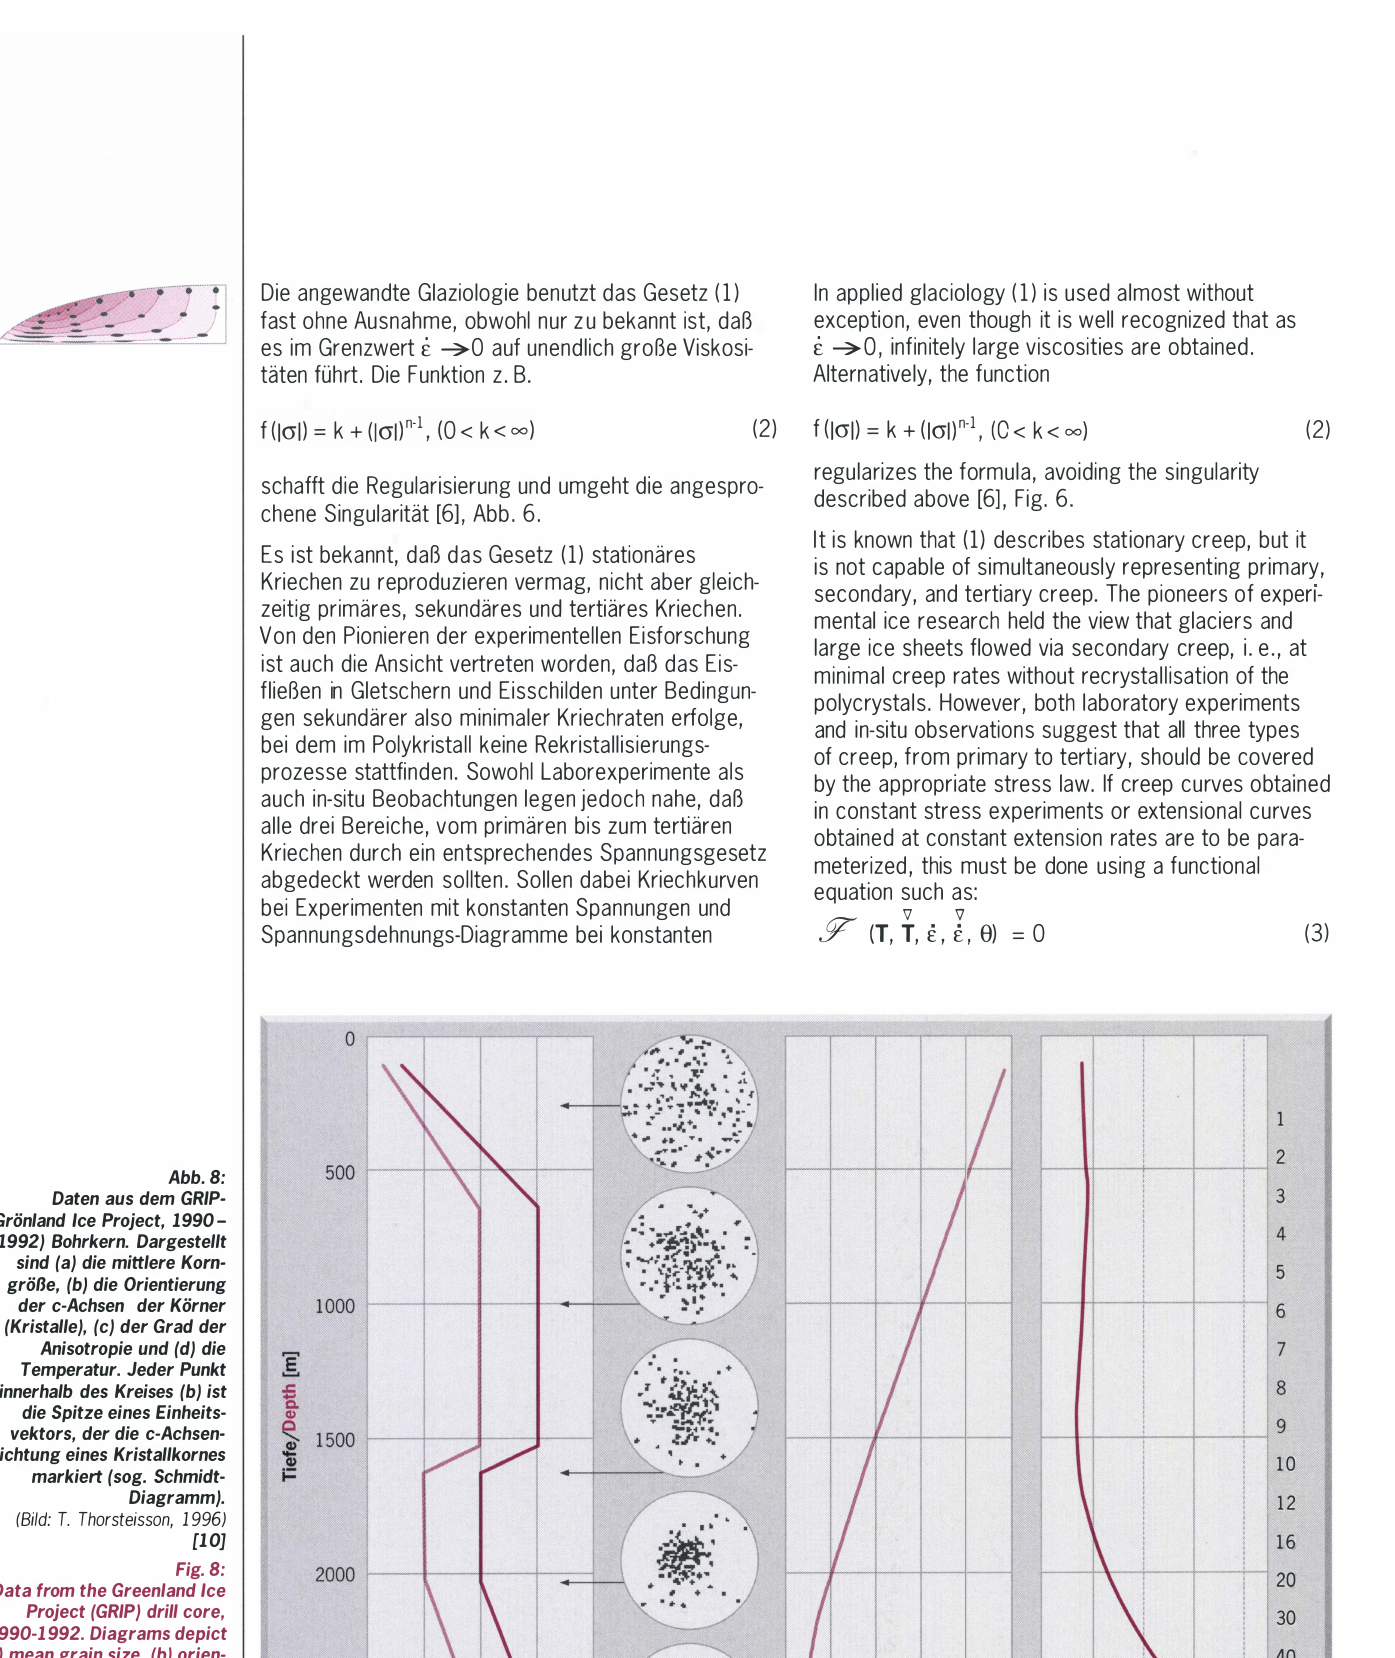
Fig.B: Data from the Greenland Ice Project (GRIP} drill core, 1990-1992. Diagrams depict (a} mean grain size, {b) orien­ tation of the c-axis of the crystals, (c) degree of anisotropy, and (d) tem- perature. Each point inside the circles shown in (b) is the vertex of a unit vector desig­ nating the c-axis direction of a crystal grain (a so-called Schmidt diagram}. (Courtesy: T. Thorsteisson,